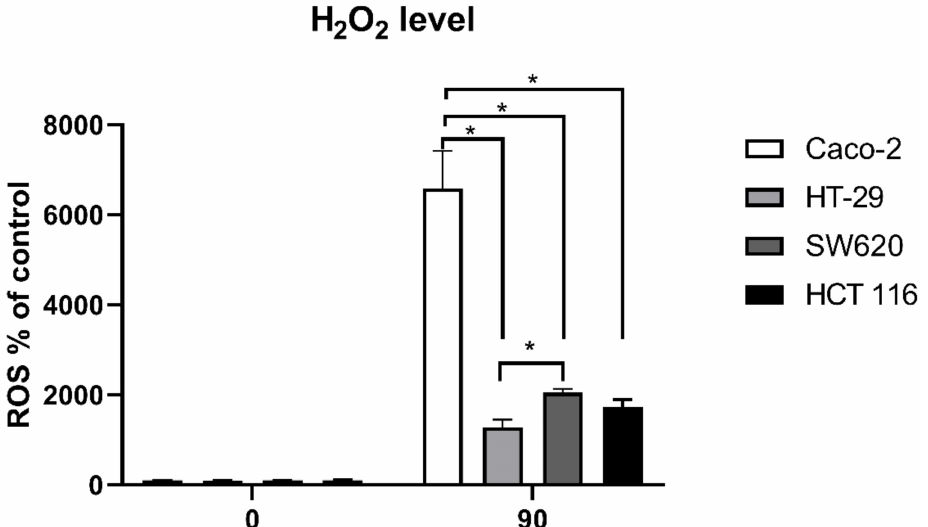
Figure 3. Intracellular ROS levels of Caco-2, HT-29, SW620, and HCT 116 cell lines. The fluorescence due to ROS accumulation triggered by 250 µ M H 2 O 2 treatment was followed over 90 min. The results present the mean ± SD from three independent experiments. Significance levels: * p <